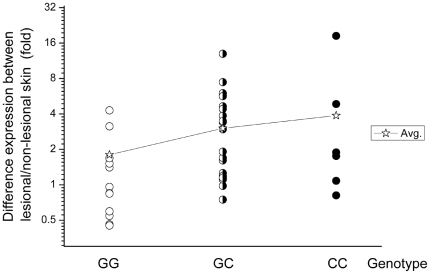
Relative expressions of XBP1 in the lesional and non-lesional skins (fold) of three patient groups with different genotypes of rs2269577: 12 patients with GG genotype, 20 patients with GC genotype, and 6 patients with CC genotype.The Avg. indicates the mean of the difference between the paired lesional and non-lesional skins within each of three genotypes. The y axis is in log2 scale.